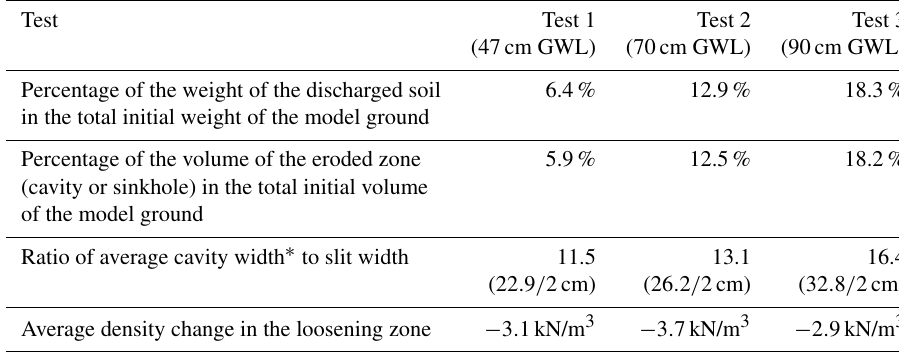
Table 4. Comparative studies of the model tests. GWL denotes groundwater level.